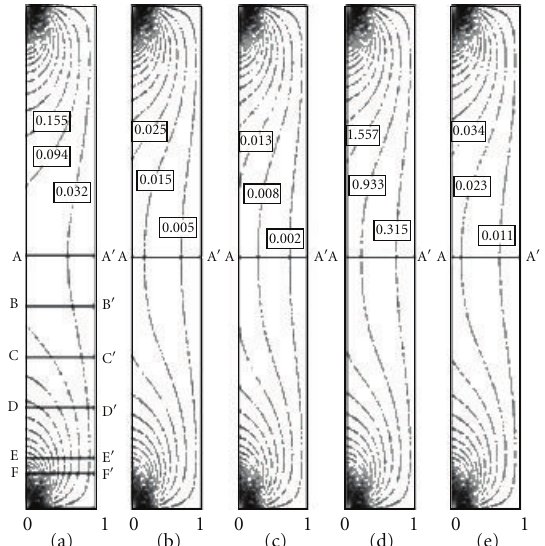
Figure 14: The distribution of dimensionless current at A-A (cid:2) with Figure 12: Distribution of dimensionless current density at T = di ff erent thickness and specific area of catalyst layer; T = 333 K, = 1 . 0 M, E 0 = 0 . 4 V, κ = 3 . 4 Ω − 1 m − 1 , D = 3 . 04 × 333K, c 0 c 0 M = 1 . 0 M, E 0 = 0 . 4 V, κ e = 3 . 4 Ω − 1 m − 1 , D e = 3 . 04 × 10 − 10 m 2 s − 1 , e e M 10 − 10 m 2 s − 1 ; (a) l = 10 μ m, a = 1 . 0 × 10 5 m − 1 ; (b) l = 25 μ m, a = solid line: l = 10 μ m, a = 1 . 0 × 10 5 m − 1 , dash line: l = 25 μ m, 1 . 0 × 10 5 m − 1 ; (c) l = 50 μ m, a = 1 . 0 × 10 5 m − 1 ; (d) l = 10 μ m, a = a = 1 . 0 × 10 5 m − 1 , dot line: l = 50 μ m, a = 1 . 0 × 10 5 m − 1 , dash dot 5 . 0 × 10 4 m − 1 ; (e) l = 10 μ m, a = 1 . 0 × 10 6 m − 1 , the dimensionless line: l = 10 μ m, a = 1 . 0 × 10 4 m − 1 , dash dot dot line: l = 10 μ m, current densities on the points of A are (a) 0.0674, (b) 0.0312, (c) a = 1 . 0 × 10 6 m − 1 . 0.0214, (d) 0.1080, and (e) 0.0275.